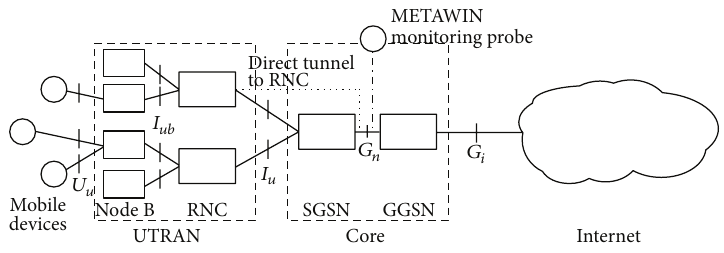
Figure 1: Simplified setup of the packet switched domain in an UMTS network including a METAWIN monitoring probe.